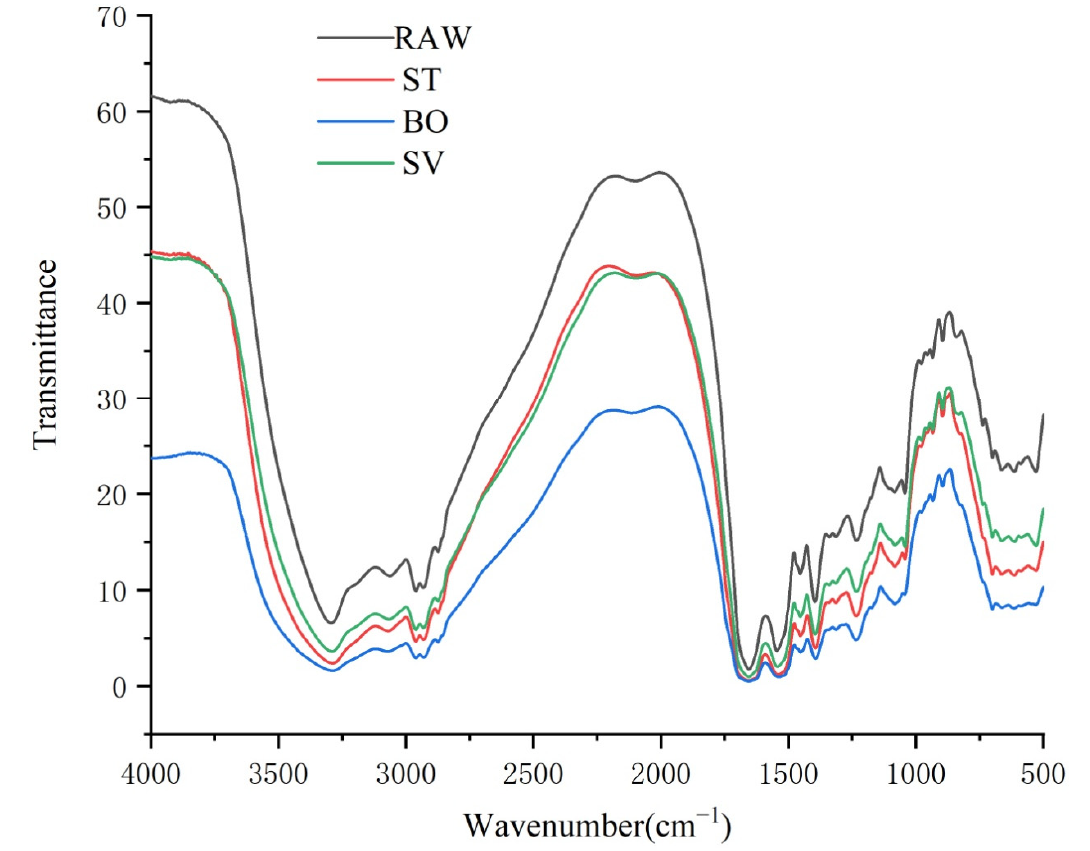
Figure 5. FT-IR spectroscopy of the squid ( symplectoteuthis oualaniensis ) mantle muscle with different cooking treatment. RAW: raw squid; ST: steaming; BO: boiling; SV: sous vide.